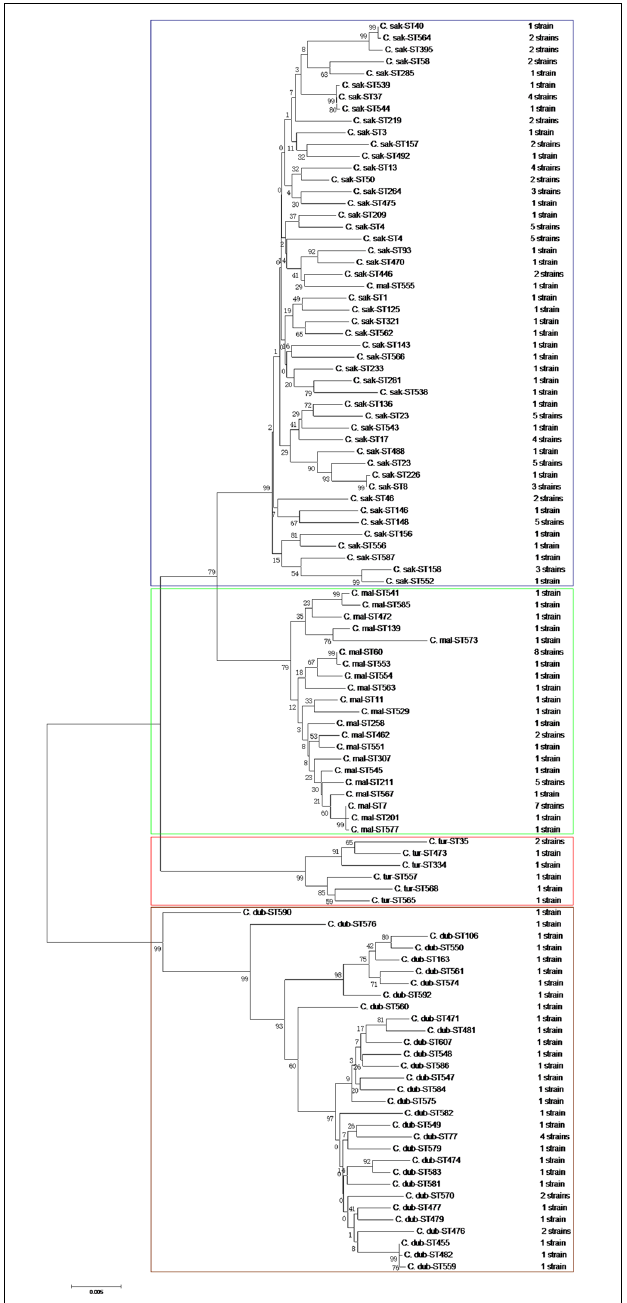
FIGURE 2 | Neighbor-joining phylogenetic tree based on the seven MLST loci (3,036 bp concatenated length) of Cronobacter spp. isolates. This tree was generated using MEGA (version 5.05) with 1,000 bootstrap replicates.